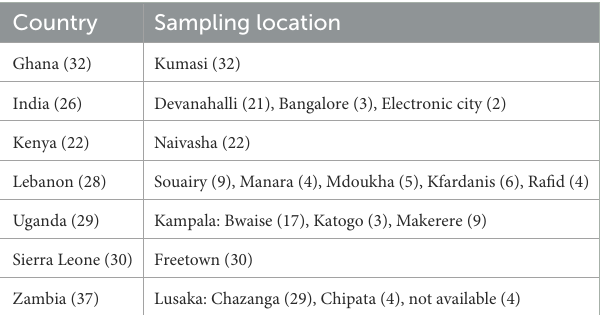
TABLE 1 The cities/communities where samples were taken per country, with number of samples taken in brackets.